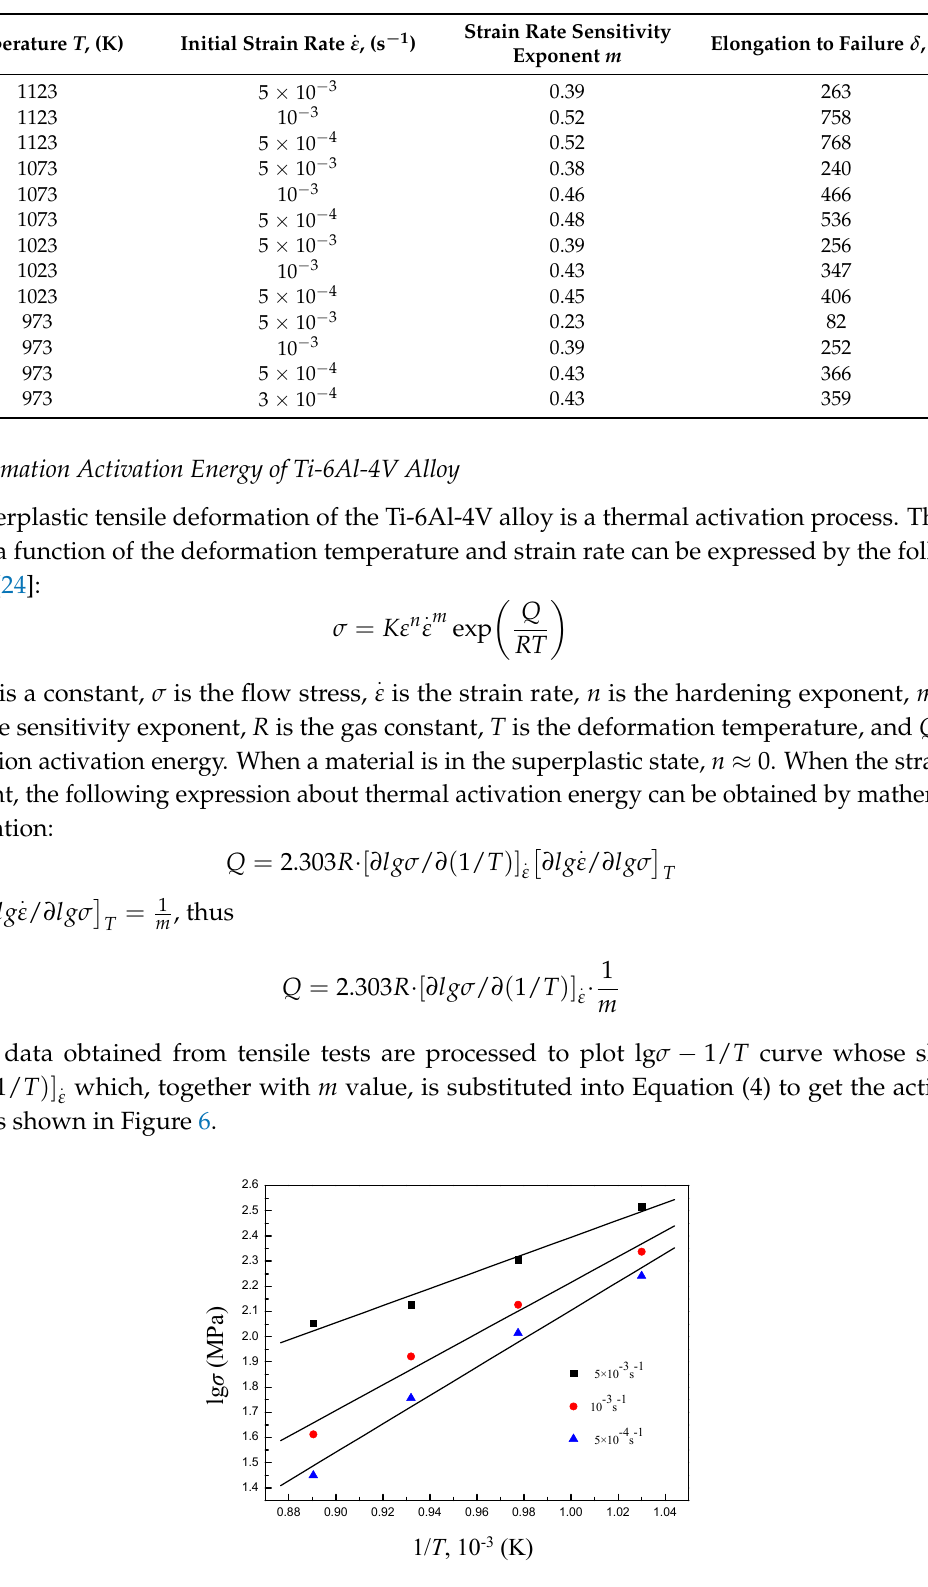
Figure 6. lg σ − 1/ T curve of Ti-6Al-4V alloy.